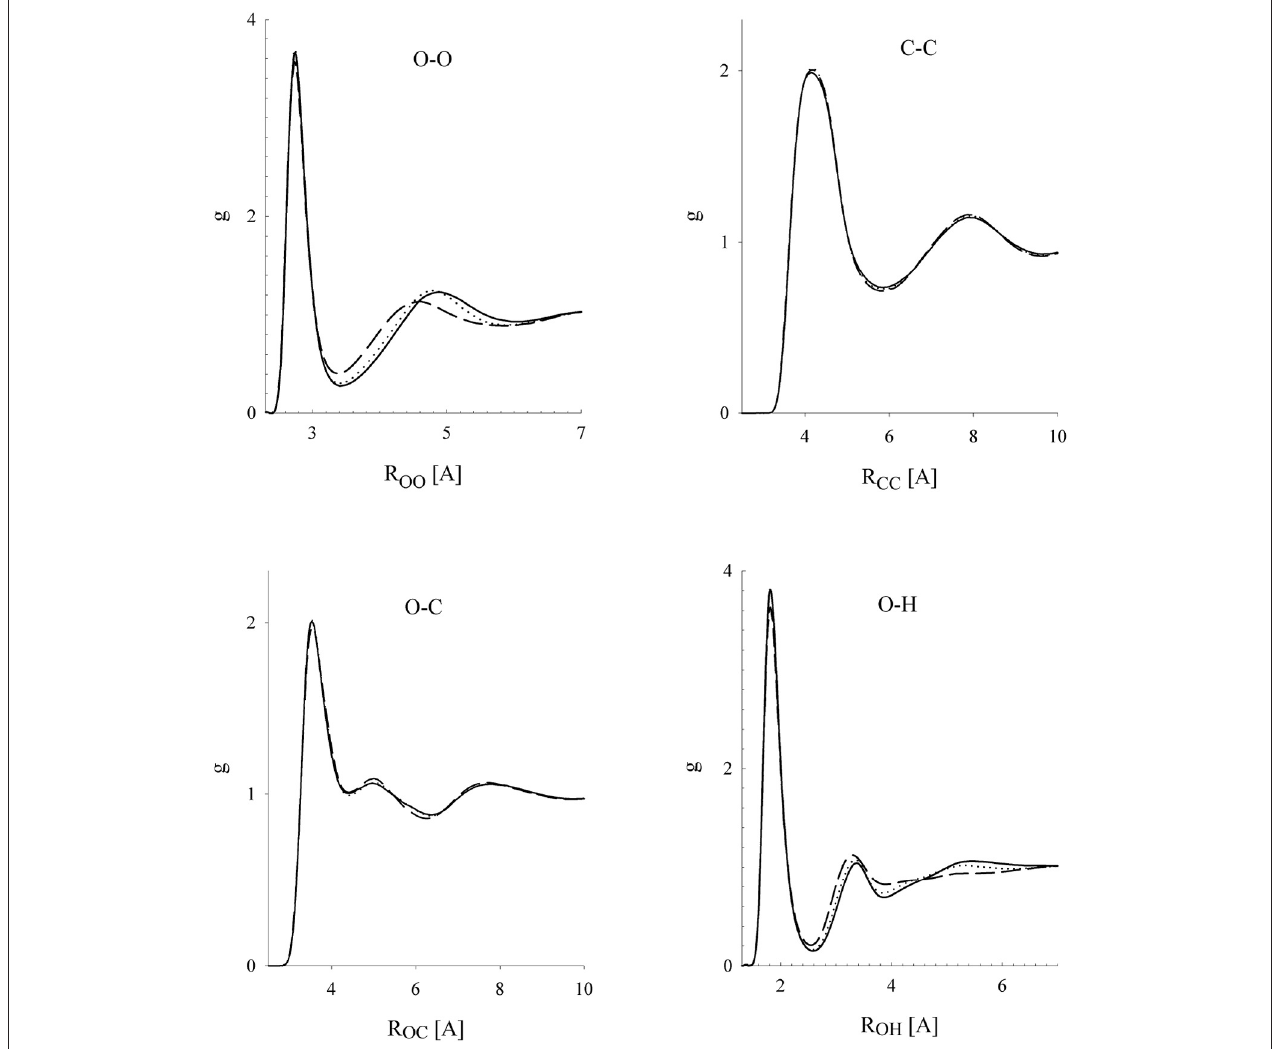
FIGURE 2 | Site-site correlation functions of methanol at density ρ = 761.9 kg/m 3 and temperature T = 298 K in dependence on the switching range: dashed line (4,6) [Å]; dotted line (4.7,6.7) [Å]; full line (5.7,7.7) [Å]. Reprinted with permission from J. Phys. Chem. B (2002)